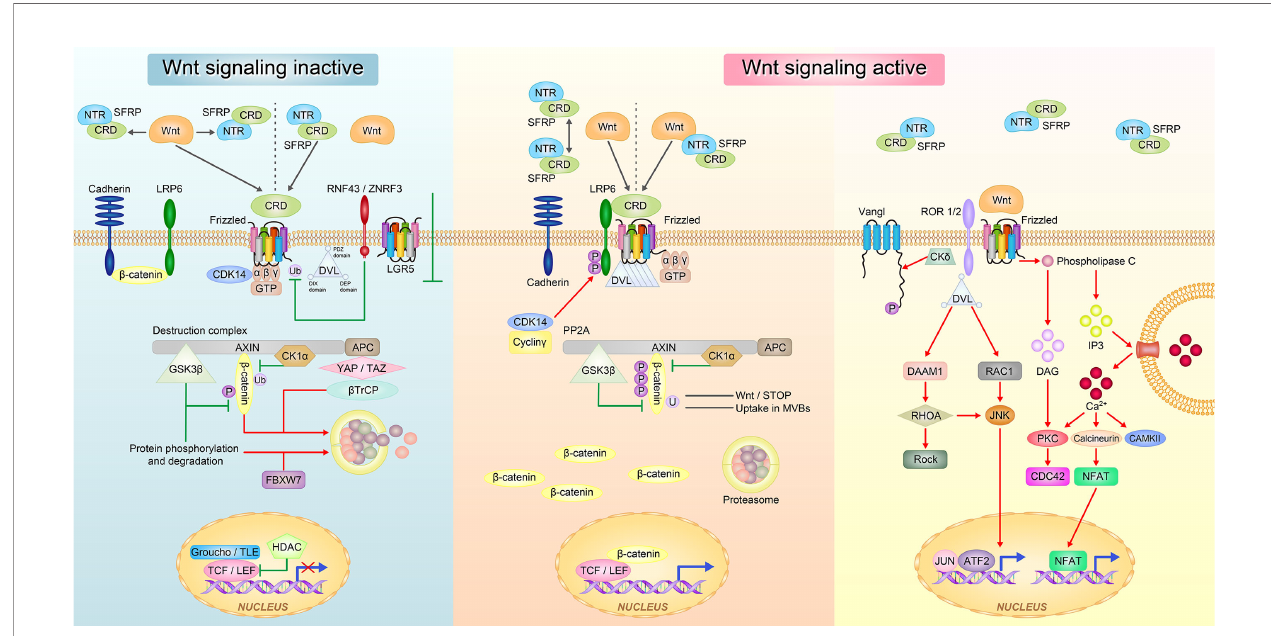
FIGURE 2 | The Wnt signaling pathway regulated by SFRPs. In the inactive state of Wnt, SFRPs sequestered Wnt proteins via either CRD or NTR domain and prevent them from binding to the frizzled receptor. SFRPs can also bind to Frizzled receptor via CRD domain to block Wnt signal transduction (left). In the active state of Wnt, SFRPs form inactive complexes by their own and Wnt proteins directly bind to Frizzled receptor; or SFRPs form complex with Wnts and interact with Frizzled receptor to promote Wnt signal transduction (right). The Wnt proteins then activate at least three different downstream signaling pathways: the canonical Wnt- b -catenin, the non-canonical planar cell polarity (PCP) and the Wnt-Ca 2+